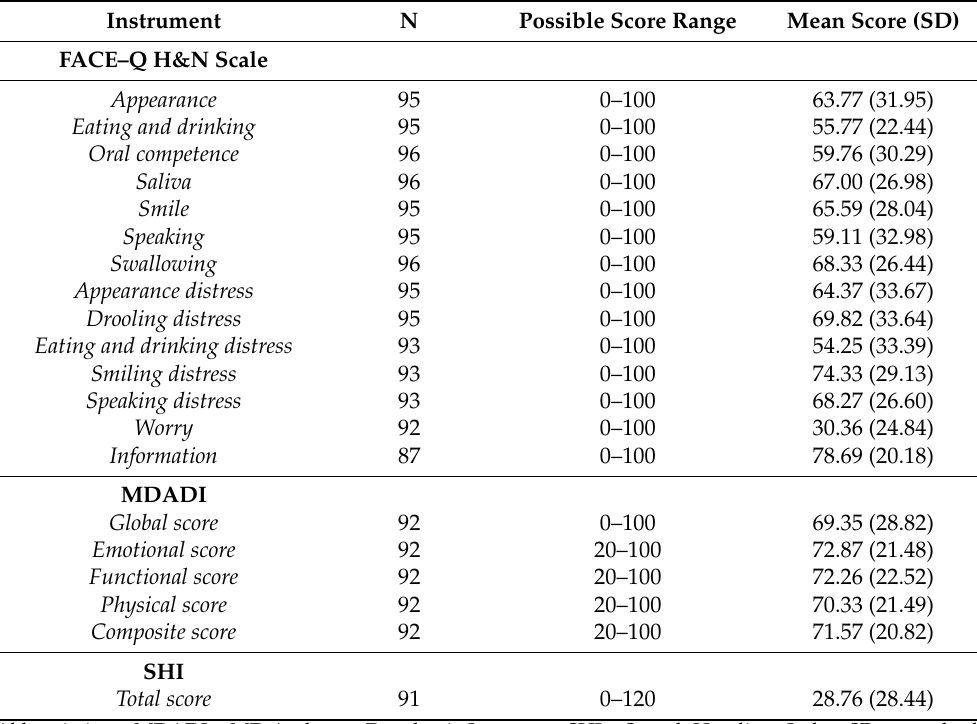
Table 2. Raw scores from cross-sectional survey of patients using the FACE-Q H&N Module, MD Anderson Dysphagia Inventory, and Speech Handicap Index. Higher scores indicate better outcomes, except for the FACE-Q H&N Worry Scale and for the SHI Total Score, where higher scores indicate greater worry and greater levels of speech-related problems,